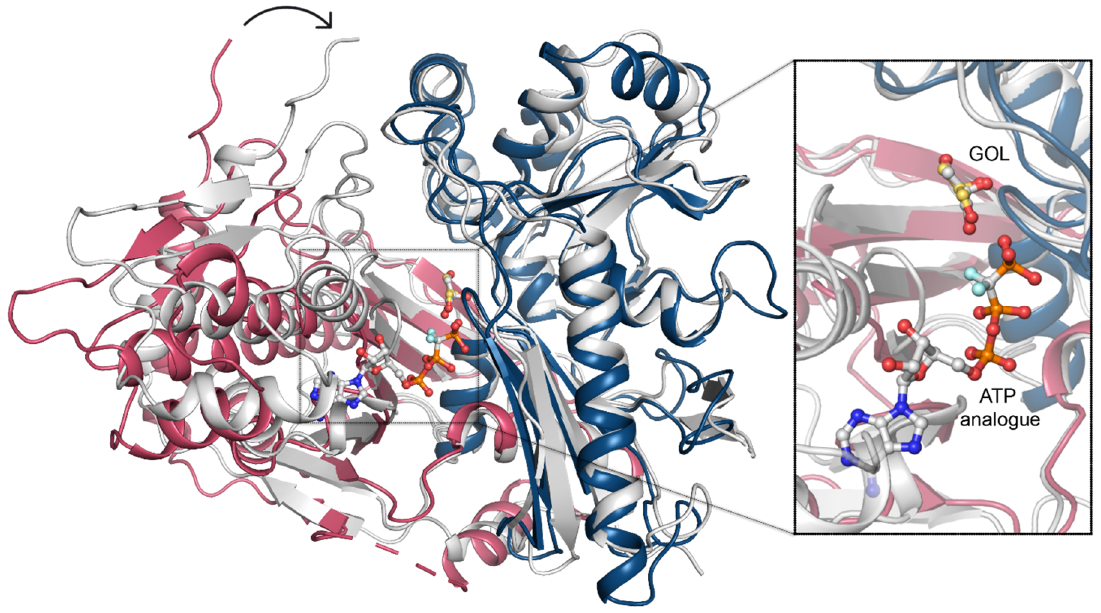
Figure 7. ATP binding. A superposition of CtGK (blue and pink cartoon) and Escherichia coli GK (1bwf, white cartoon) with ligands shown in ball-and-stick representation. Inset shows an enlargement of the ligand-binding site.